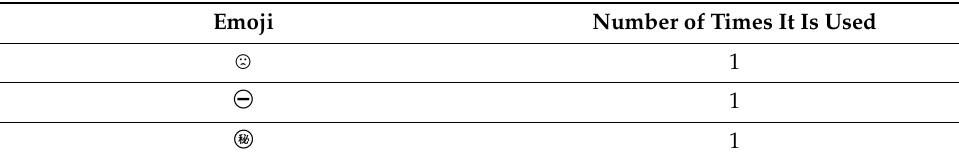
Table 11. Artifacts Found in direct.emojis Record.